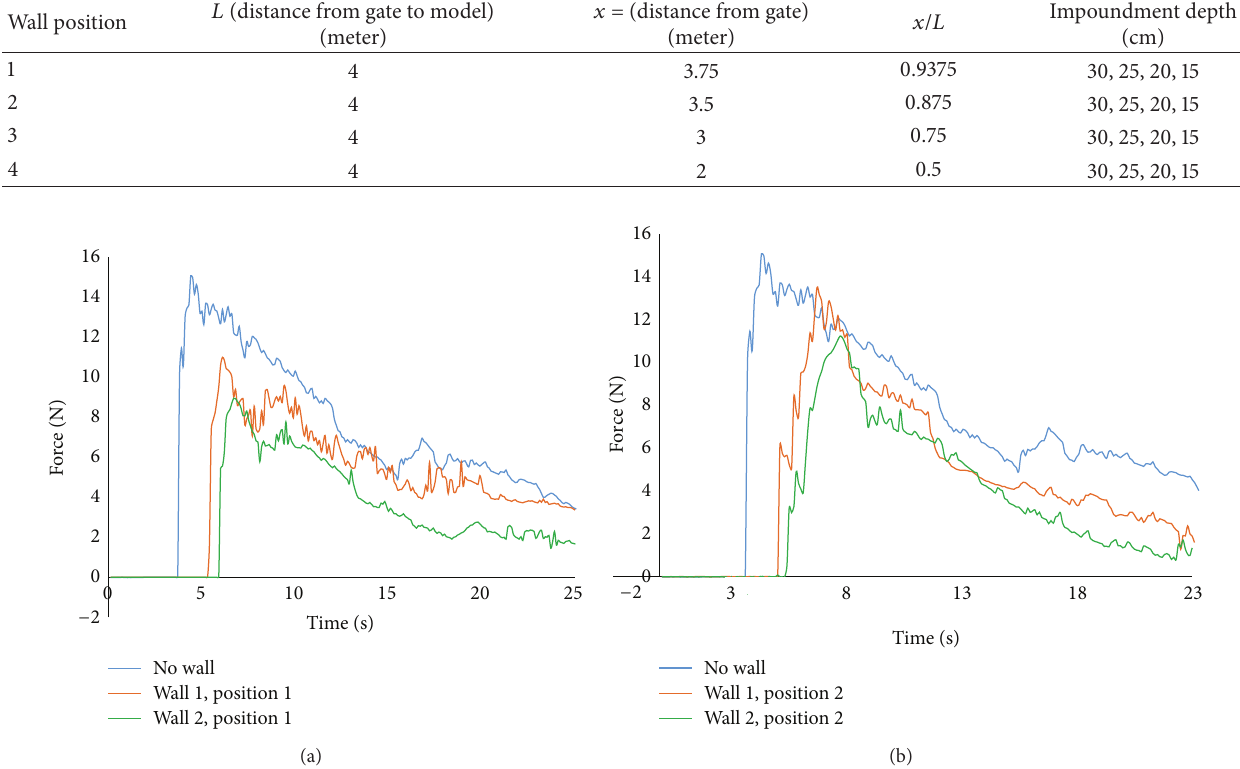
Figure 3: Force time history with sea wall 1 and sea wall 2 placed on positions 1 and 2, respectively.